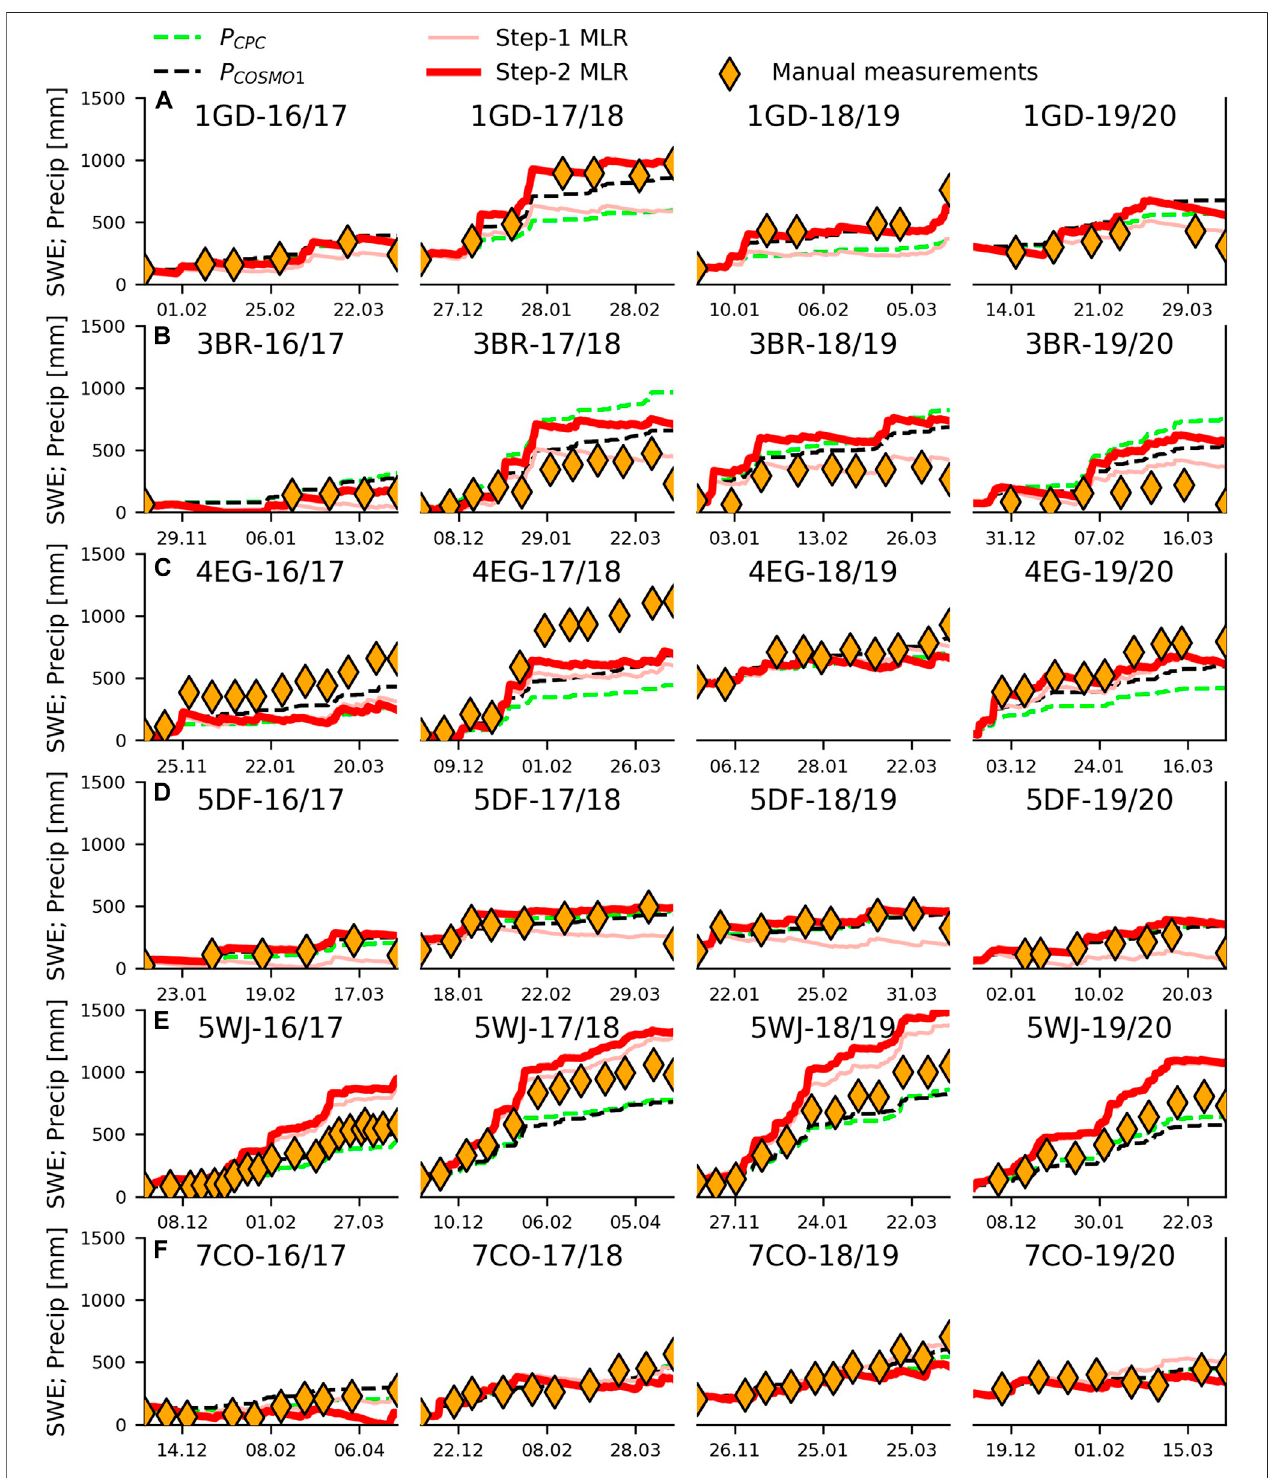
FIGURE11| Thetwice-monthlySWEmeasurementsofsixstationscomparedwiththecumulativeprecipitationandMLRestimatesforthefourwinterseasons (A) : Schreckfeld (elevation: 1,950 m) (B) : Braunwald (1,310 m) (C) : Egginer (2,620 m) (D) : Davos (1,560 m) (E) : Weiss fl uhjoch (2,540 m) (F) : Corvatsch (2,697 m).